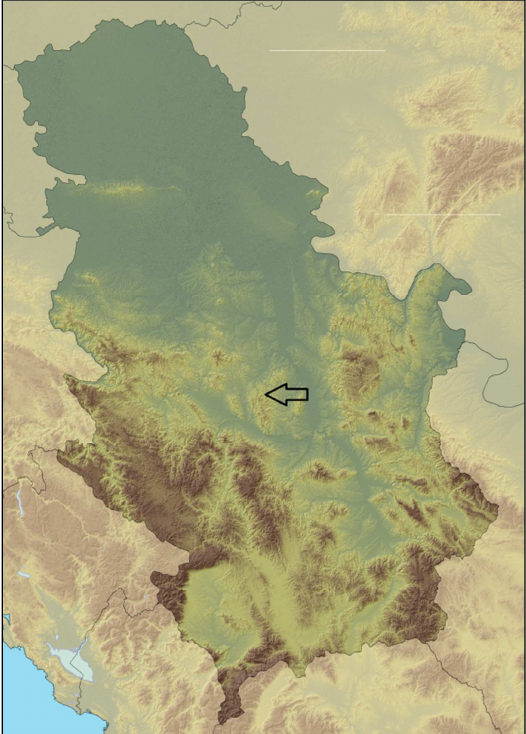
Figure 1. Position of the Gledi ć Moutains on the map of the Republic of